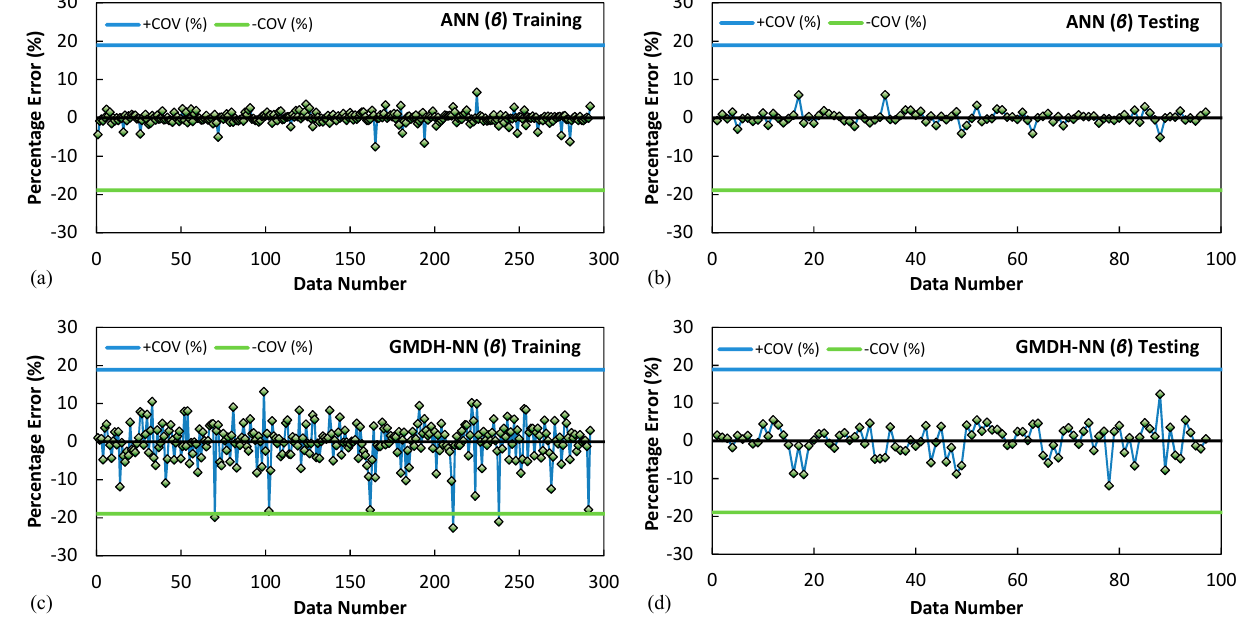
Figure 19. Error values in test and train stages of β in proposed models: ( a , b ) ANN ( β ); ( c , d ) GMDH-NN ( β ).